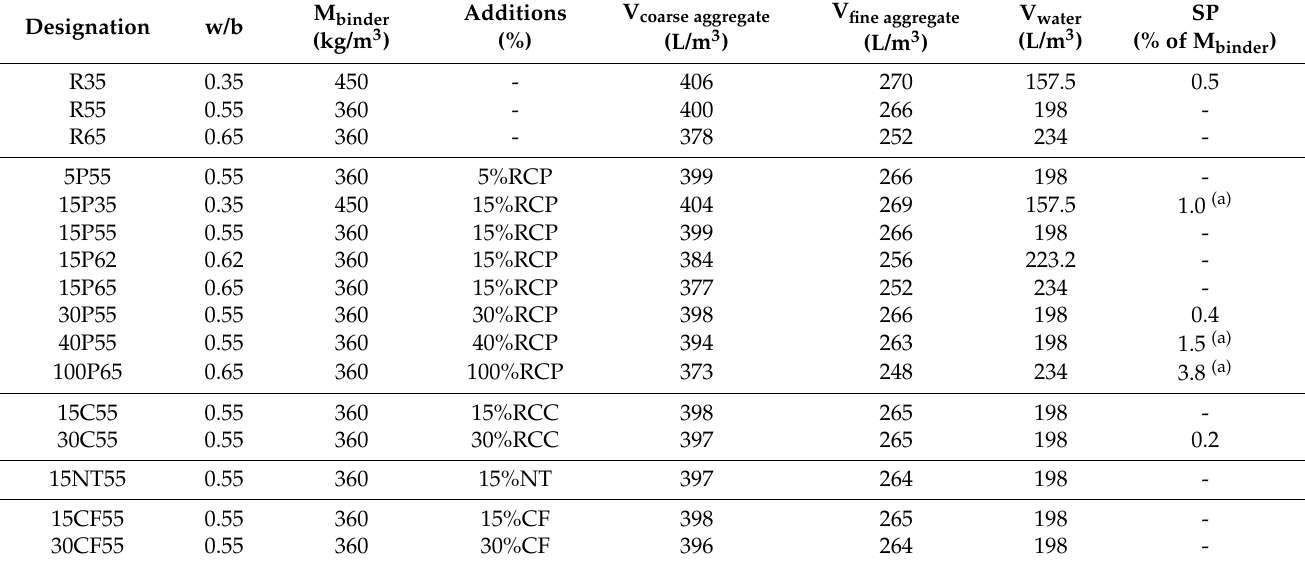
Table 3. Concrete mixture compositions.